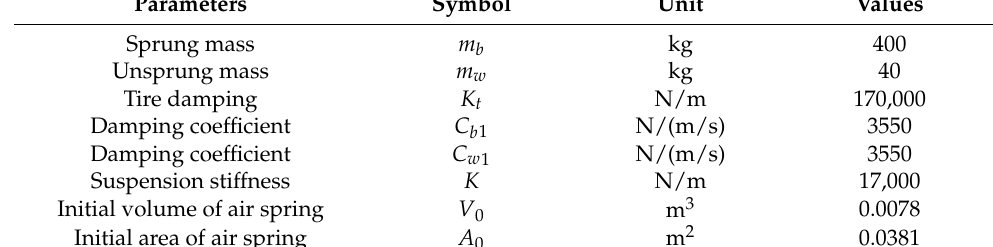
Table 3. Model parameters of two-degree-of-freedom quarter vehicle passive air suspension system.